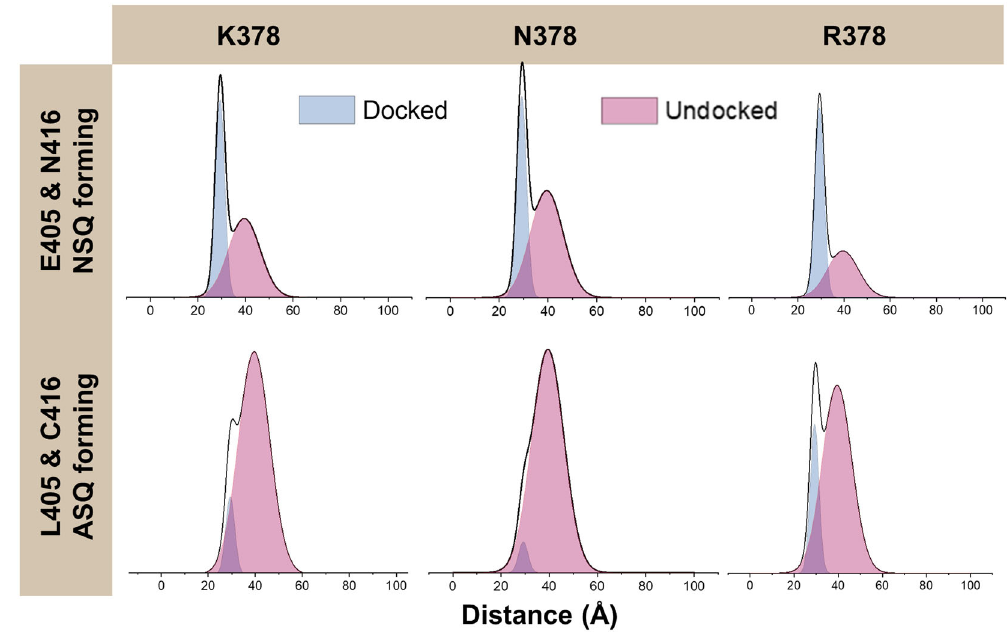
Fig. 5 H378 substitutions affect CTT conformation in dark and in light. PDS distance distributions between the fl avin and nitroxide radicals for the various H378 dCRY variants. Each spectrum was fi t to a combination of docked (L405E/C416N distance distribution) and undocked (WT distance distribution) states. The H378R/K/N variants show a mixture of docked and undocked states even in the dark state proxy of L405E/C416N (top